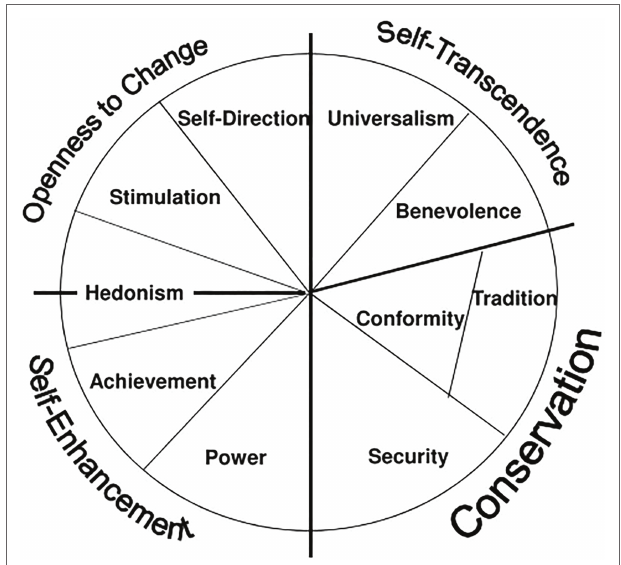
FIGURE 1 | The Circular Structure of Values Relations and Inter- Relatedness. This figure represents the theoretical model of relations among ten types of value. From Schwartz (2012b). The figure has been used with the permission of the